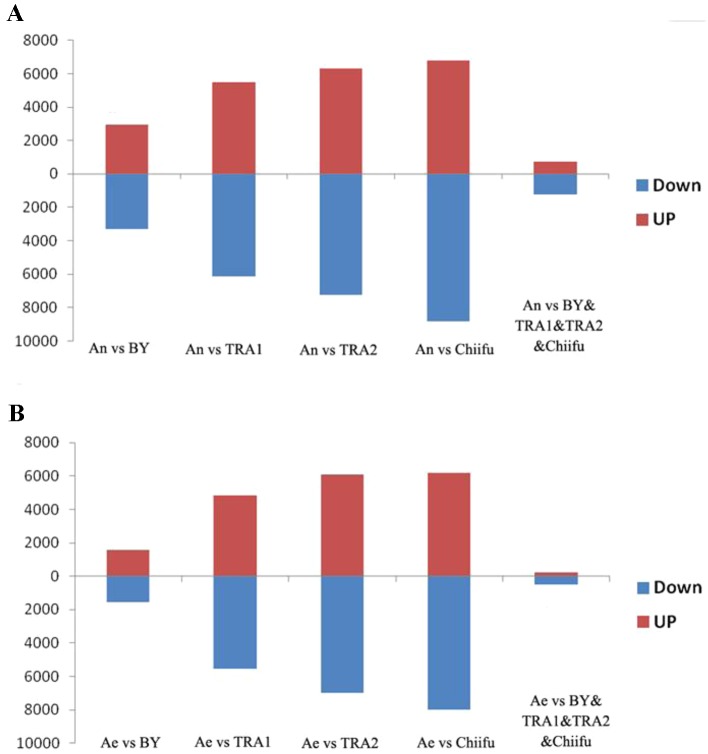
Histograms of the up- and downregulated gene numbers in each of the four pairwise comparisons between An-subgenome (A) and RBR (B) and four varieties of B. rapa: Chiifu-401, BY1, TRA1, and TRA2. An represented An-subgenome of B. napus ZS11 and Ae represented RBR.